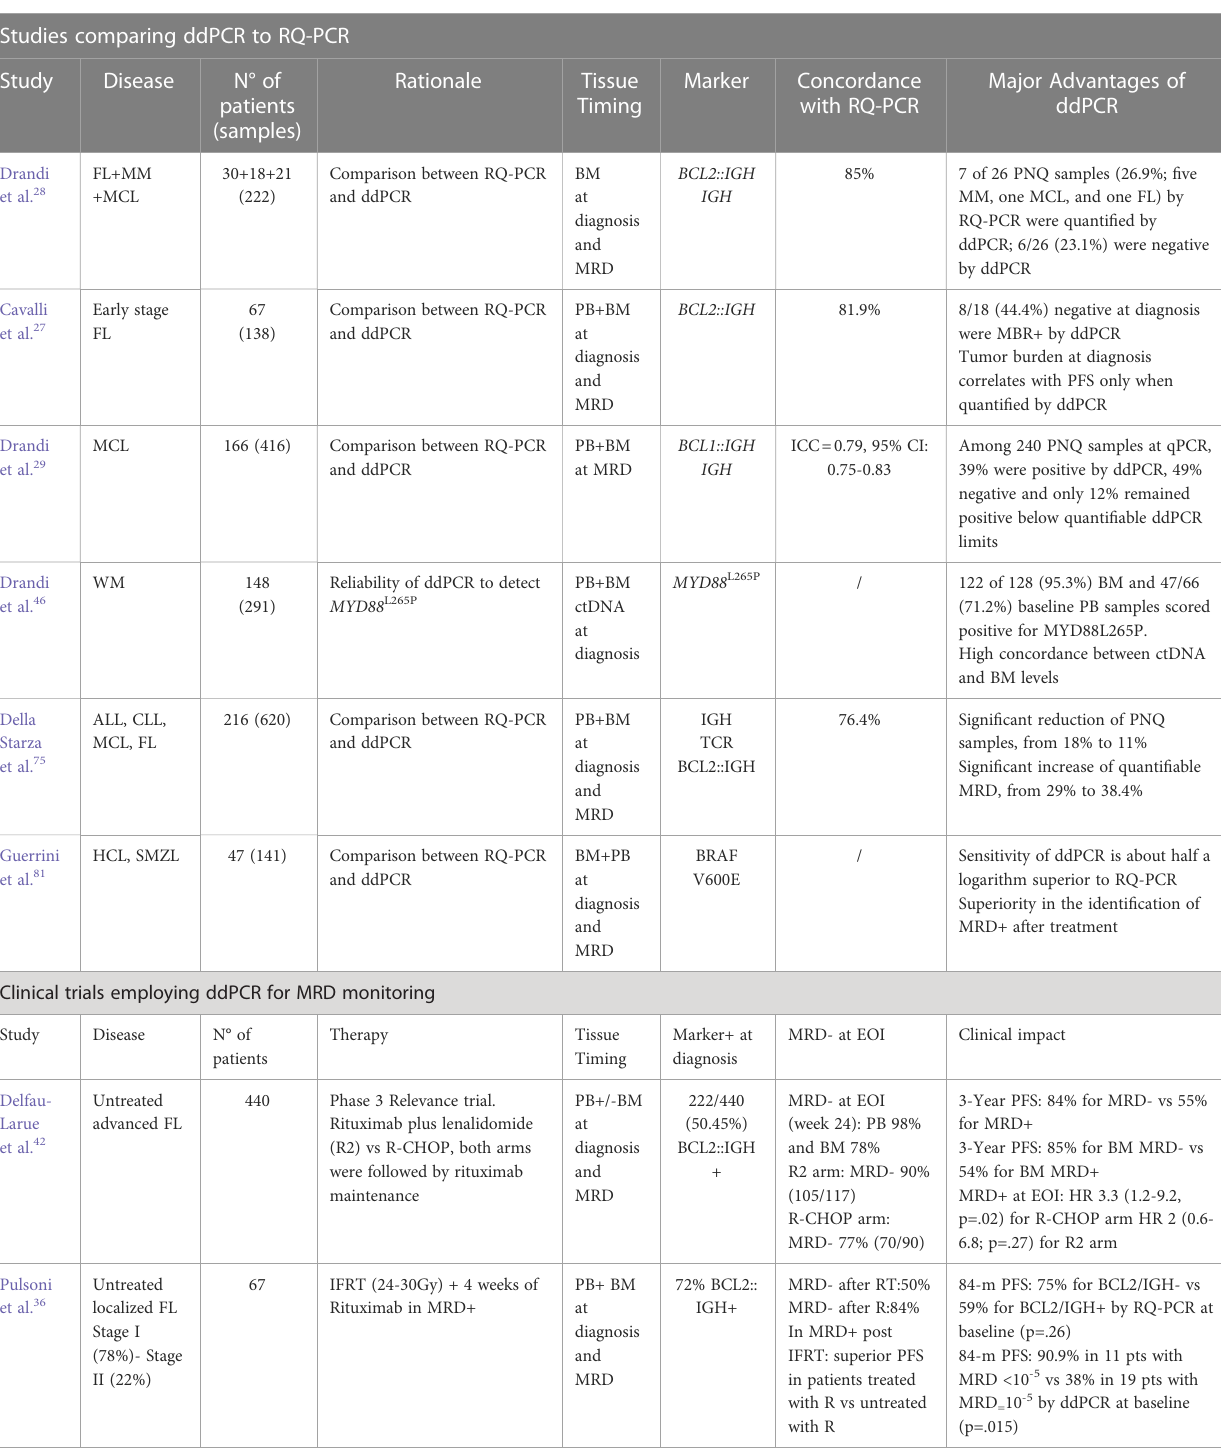
TABLE 1 Experiences reporting on ddPCR and MRD in lymphoproliferative